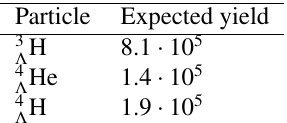
Figure 4. Left) reconstructed invariant mass of 3 Λ H 3-prong decay mode; right) reconstructed invariant mass of 2-prong decay mode Table 2. Expected particle yield for 10 weeks of NICA running